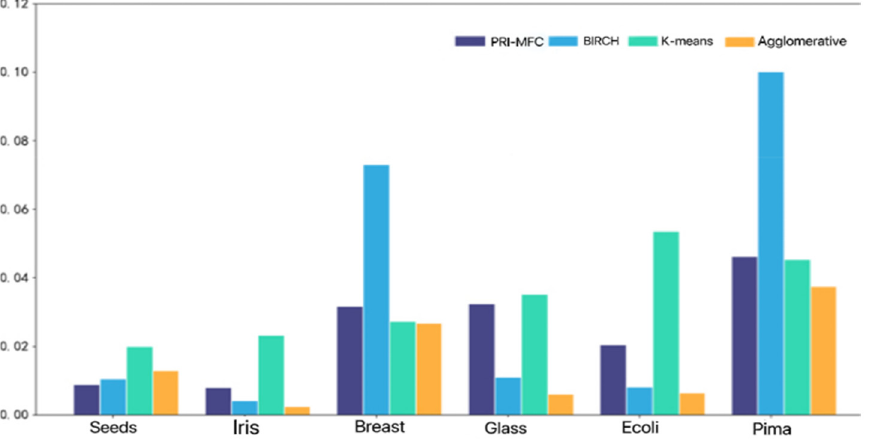
Figure 5. Comparison of running time of clustering algorithm on UCI datasets.